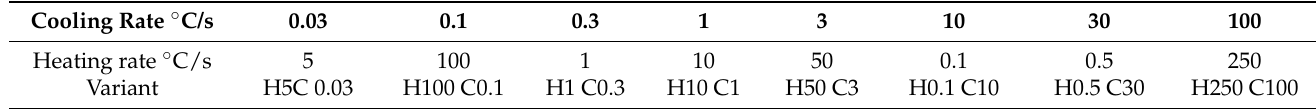
Table 4. The chosen variants for analyzing austenite transformation temperatures in the cooling phase, final microstructure, and hardness.